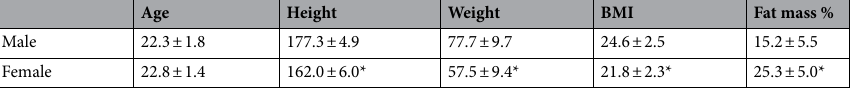
Table 1. Characteristics of participants. Data are presented mean ± SD. *Significant difference between male and female P <